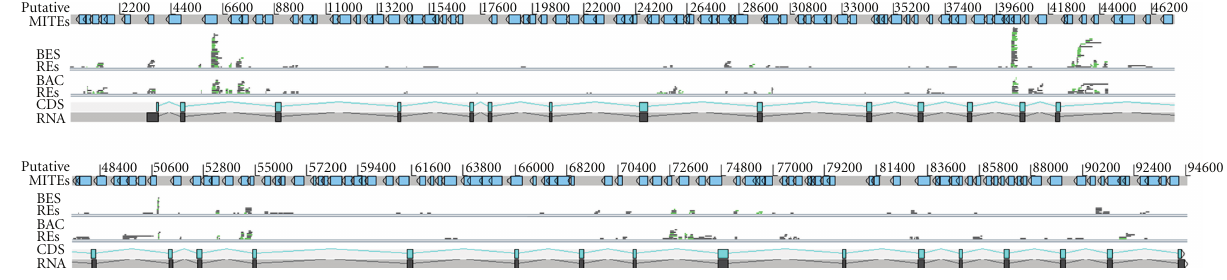
Figure 4: Identification of putative miniature inverted repeat transposable elements (MITEs) (blue rectangles indicating direction), and de novo mapped repetitive elements identified from BAC end sequences (BES REs) and BAC full insert sequences (BAC REs), within the gene protein coding sequence (CDS) and transcript sequence